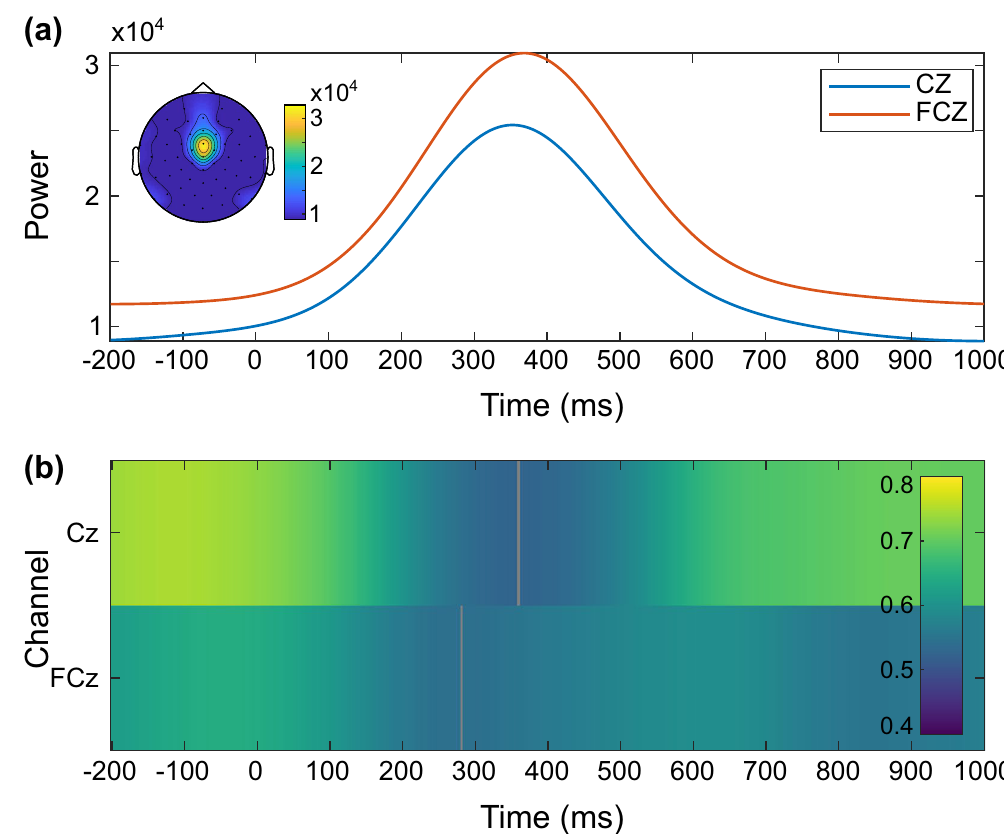
Figure 5. Time course of total theta power and correlation between resting and inhibition-related theta power in the C-cluster. ( a ) Participants’ grand average showing the course of inhibition-related total theta power in the frequency band of 5 Hz in the C-cluster from 200 ms before stimulus onset to 1000 ms after the stimulus onset at electrodes Cz (blue) and FCz (orange). The scalp topography corresponds to the time–frequency window of 367 ms and 5 Hz. ( b ) Correlation between resting-state theta activity and inhibition-related total theta activity in the C-cluster from 200 ms before stimulus onset to 1000 ms after stimulus onset for the electrodes Cz and FCz. Only significant correlations with p ≤ .05 after a channel-by-channel correction with the false discovery rate (FDR) method are shown. The grey areas were not significant after FDR correction. The correlation coefficient r is indicated by